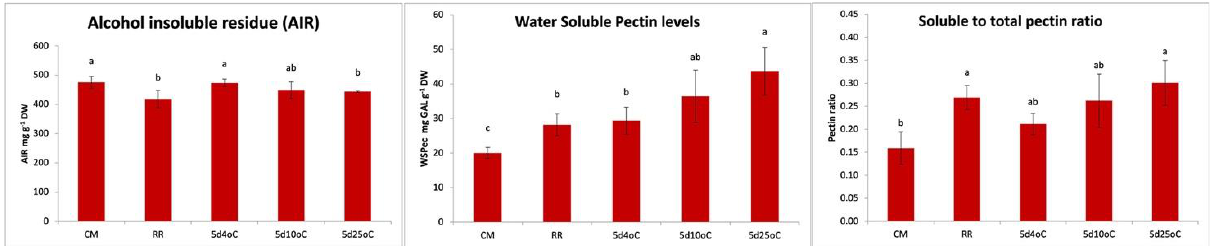
Figure 5. Alcohol insoluble residue (AIR), water soluble pectin, and soluble total pectin of tomato fruit cv. Chondrokatsari during their late maturation and after postharvest storage (5 d) at different temperatures (4, 10 and 25 °C). Significant differences between treatments were determined by one- way ANOVA and false discovery rate (FDR) correction. Bars represent means (±SE) of three biolog- ical replications.